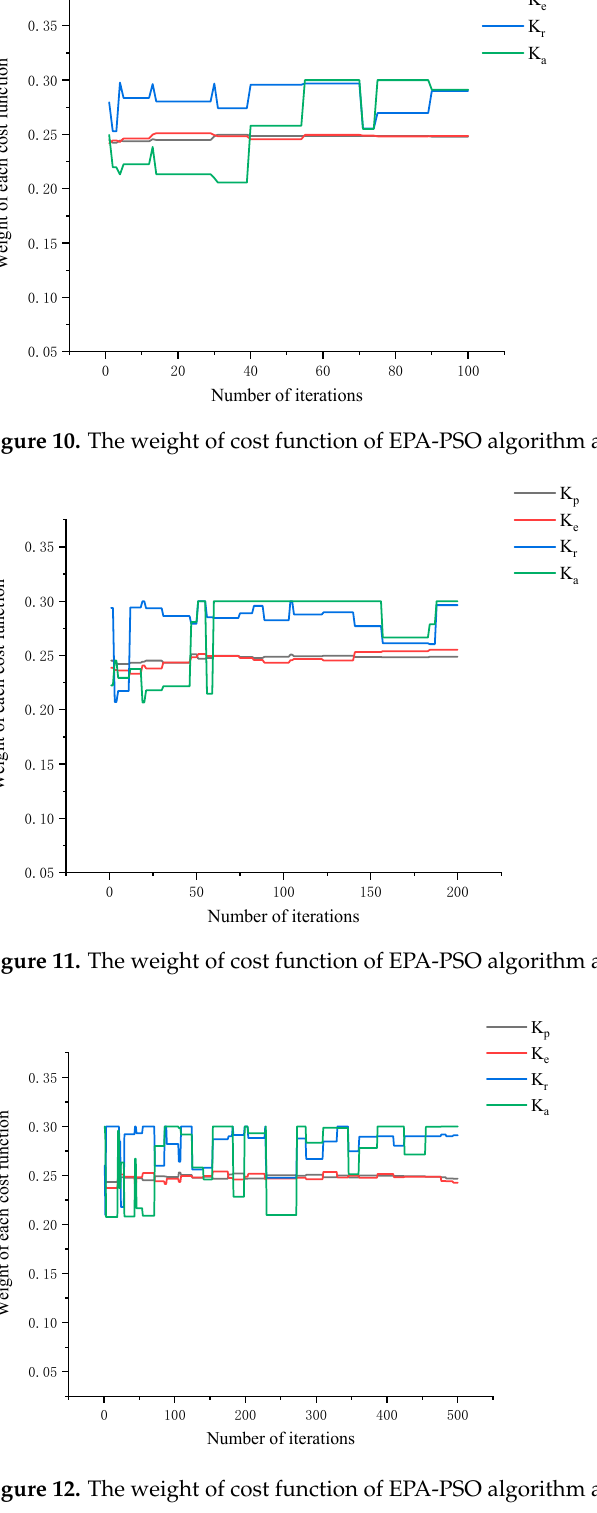
Optimal value of EPA-PSO algorithm Figure 13. Numerical comparison of energy cost functions after 100 iterations. 0 PSO EPA-PSO M-PSO Figure 14. Numerical comparison of energy cost functions after 200 iterations.